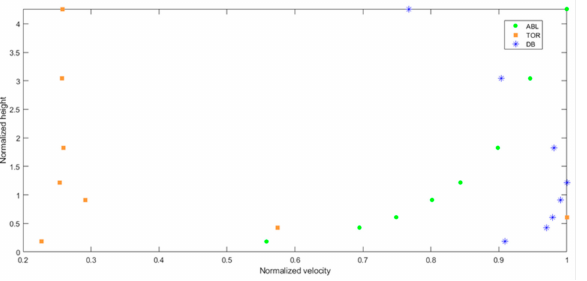
Figure 8. Normalized profiles of peak downburst velocity, the mean atmospheric boundary layer velocity and peak horizontal tornado velocity at each Cobra probe height. The height is normalized with the platform